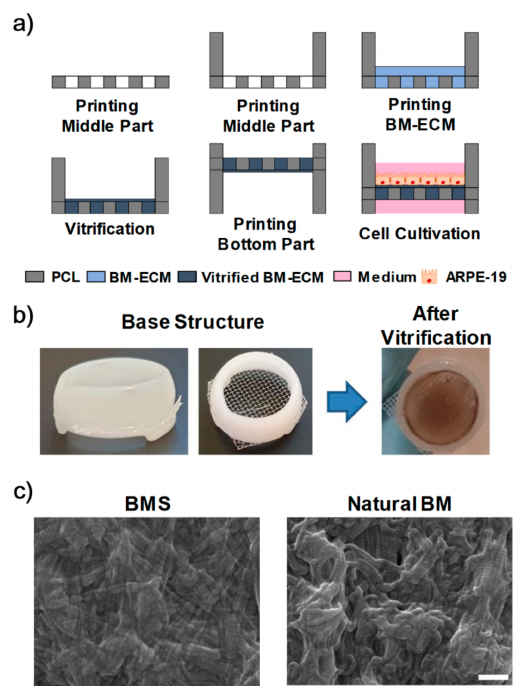
Figure 3. Development of Bruch’s membrane-mimetic substrate (BMS). ( a ) 3D printing process for BMS. ( b ) Photographs of fabricated products at two different stages. ( c ) SEM images of BMS and natural BM. Scale bars: 500